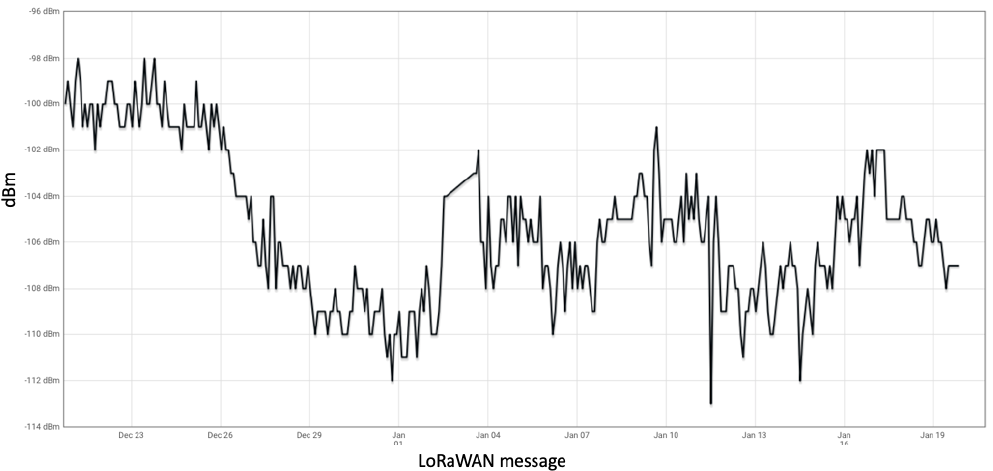
Figure 12. Messages along with signal strength (RSSI) inside greenhouse.